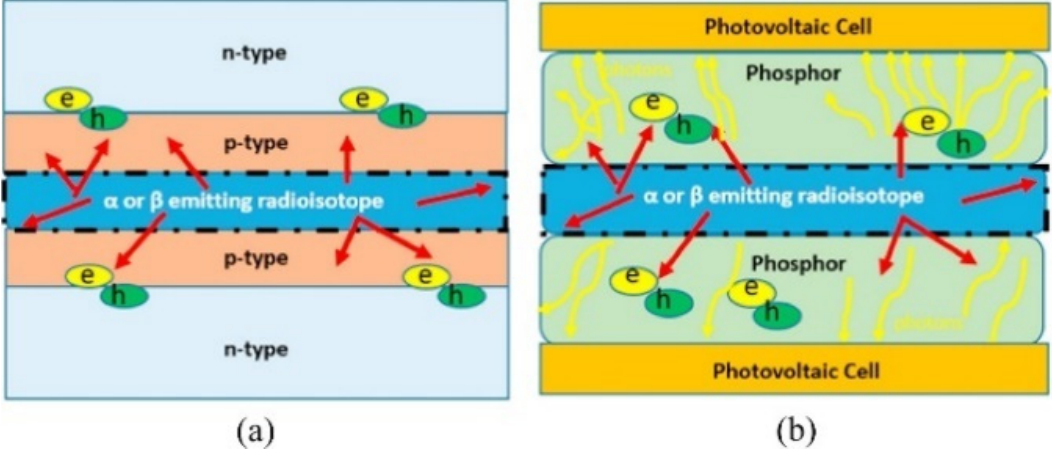
Figure 19. Illustration of ( a ) betavoltaic and ( b ) beta ‐ photovoltaic cell energy conversion. Copyright permission from [130].